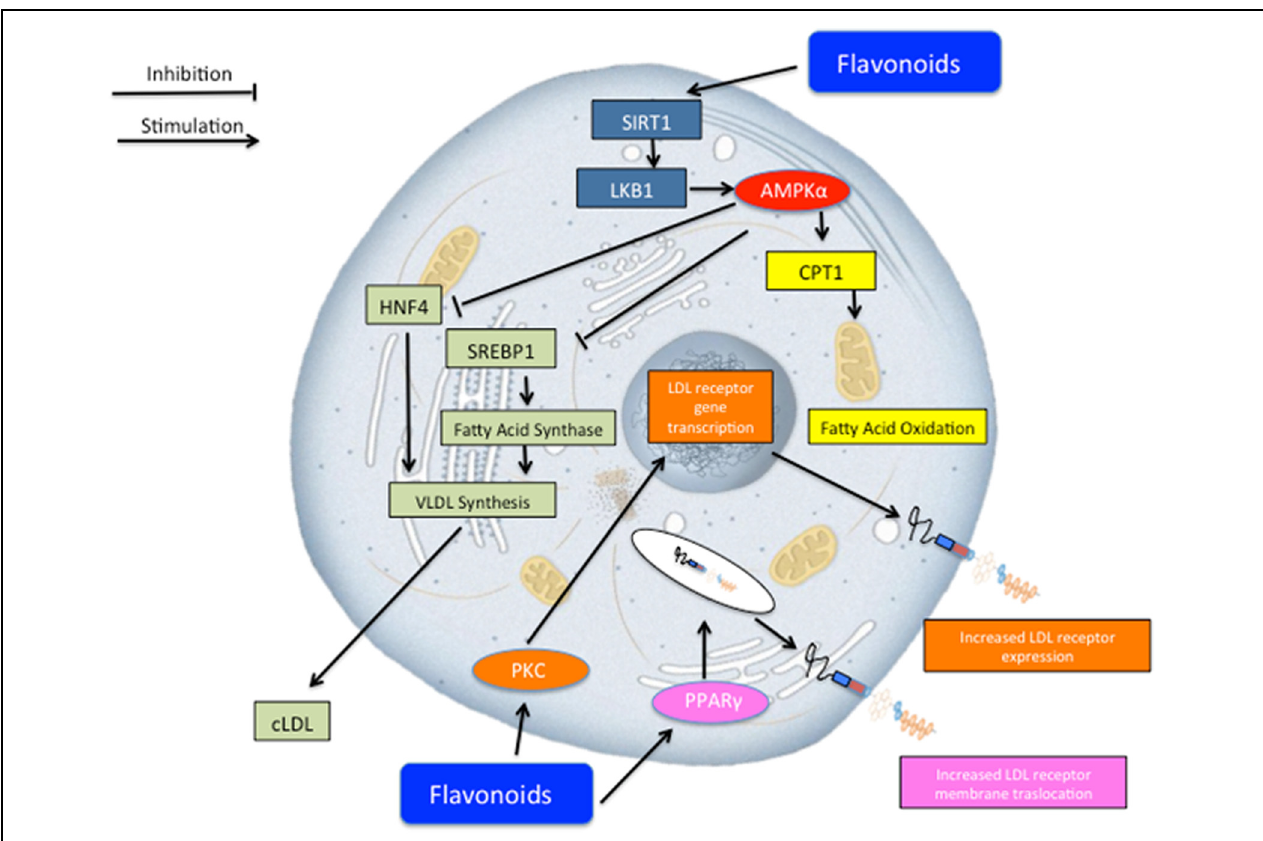
FIGURE 4 | Schematic representation of potential lipid lowering effect of Bergavit R (cid:2) (Bergamot-derived flavonoids: 150 mg of flavonoids, with 16% of neoeriocitrin, 47% of neohesperidin and 37% of naringin, daily). Several mechanisms may concur to regulate lipid homeostasis. Flavonoids may lead to an increase of lipid consumption via activation of mitochondria oxidation and at the same time flavonoids decrease very low-density lipoproteins (VLDL) synthesis. Other potential mechanisms include increased LDL receptor gene transcription via protein kinase C (PKC) activation and increased membrane translocation of this receptor via peroxisome proliferator-activated receptors gamma (PPAR- γ ) activation. AMPK- α , adenosine monophosphate-activated protein kinase alpha; CPT1, carnitine palmitoyltransferase 1; HNF4, hepatocyte nuclear factor 4; SREBP-1, sterol regulatory element-binding protein